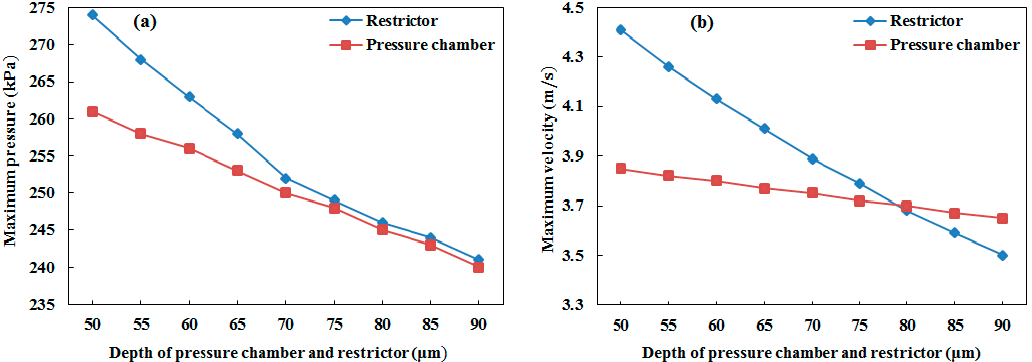
Figure 14. Restrictor and pressure chamber depth variation effect on ( a ) maximum pressure at the pressure chamber and ( b ) maximum velocity at the nozzle inlet.